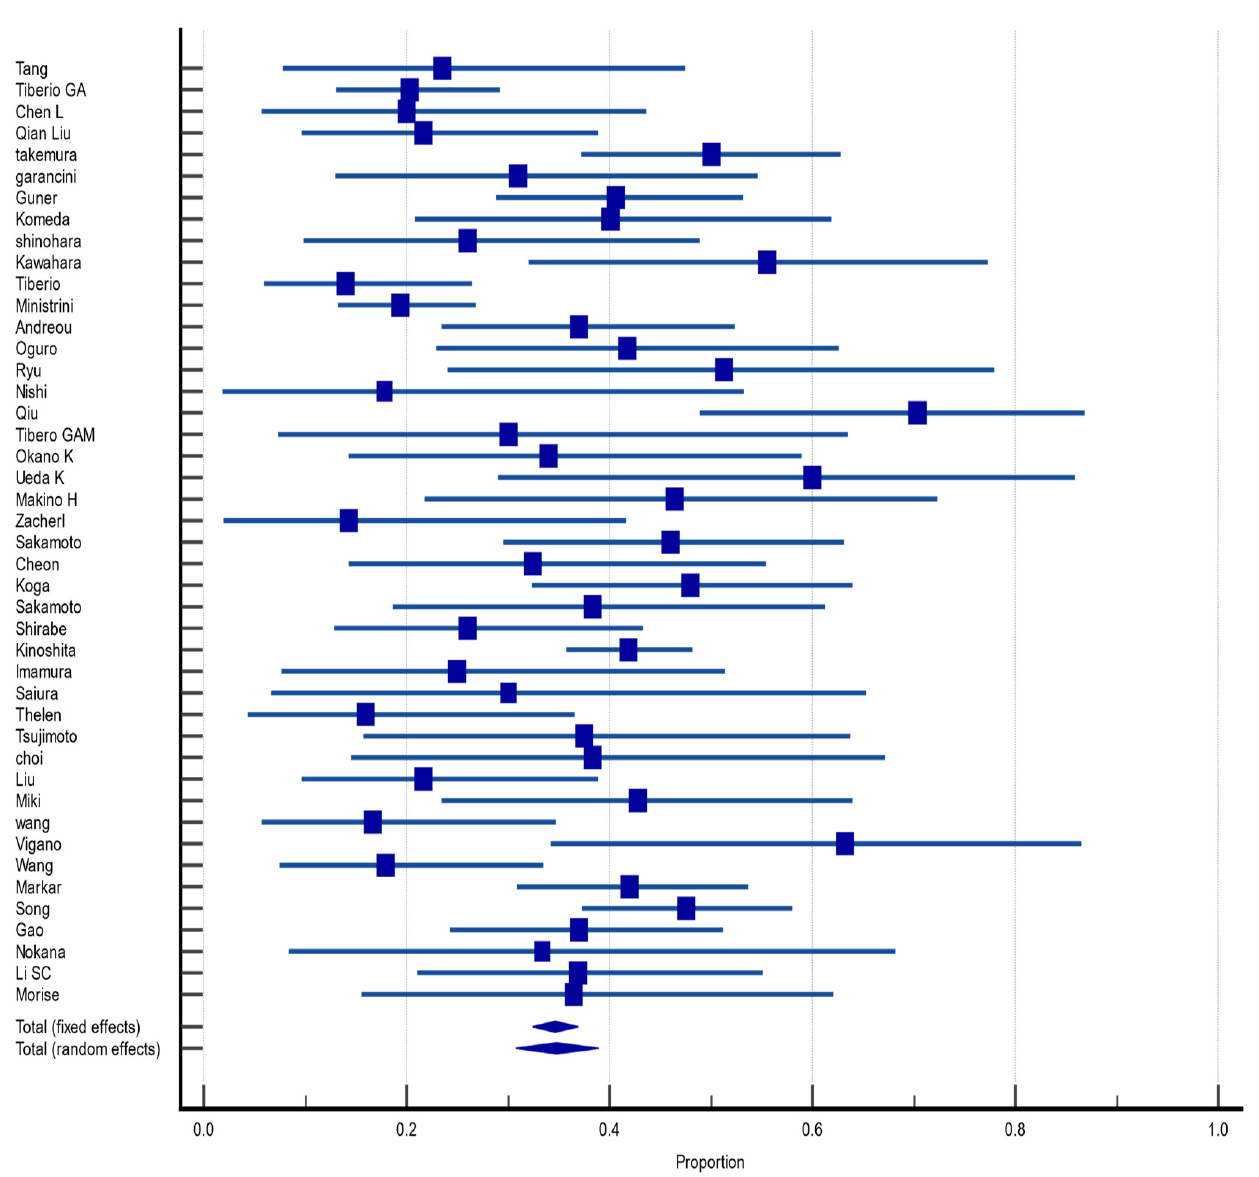
Figure 3. Forest plot of overall survival at 3 years after hepatectomy for gastric cancer liver metastasis (GCLM). Description of the proportion and confidence intervals at 95% in the studies that reported 3-year overall survival.